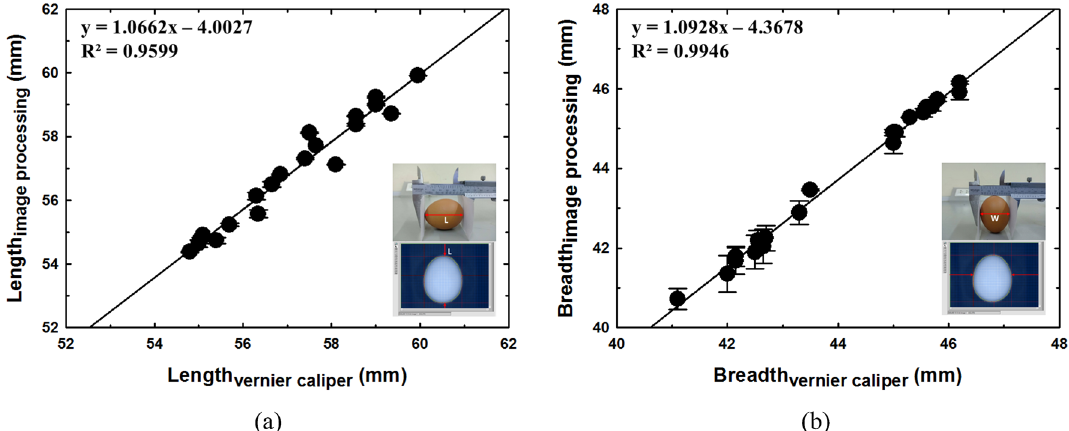
Figure 5. Measurement of external physical characteristic and calibration ( a ) length and ( b ) breadth.